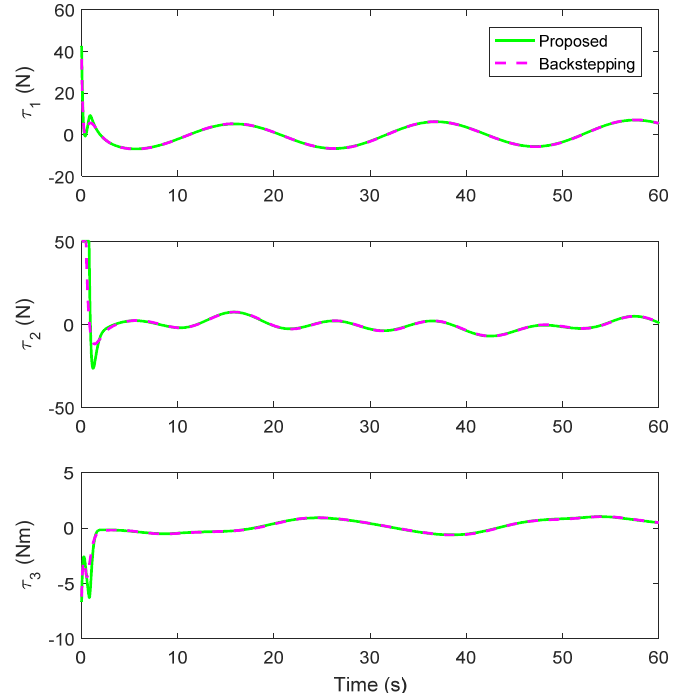
Figure 16. Pro fi le of the control inputs (Case 2).